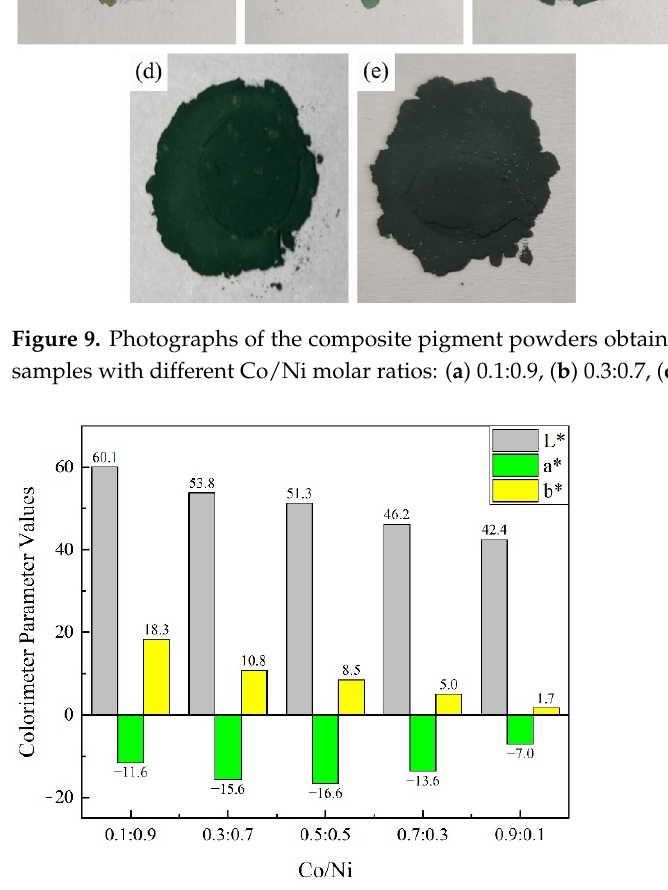
Figure 10. Colorimetric parameters of the composite pigment powders obtained after calcination at 800 °C for samples with different Co/Ni molar ratios: 0.1:0.9, 0.3:0.7, 0.5:0.5, 0.7:0.3, 0.9:0.1.